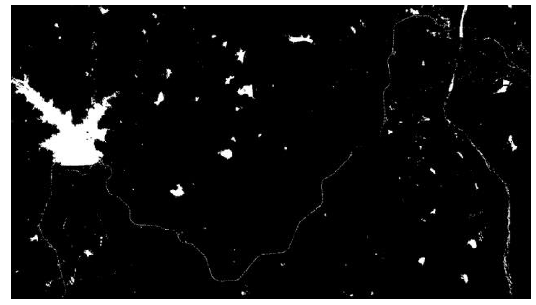
Figure 10: Paleru reservoir with canal from figure-7